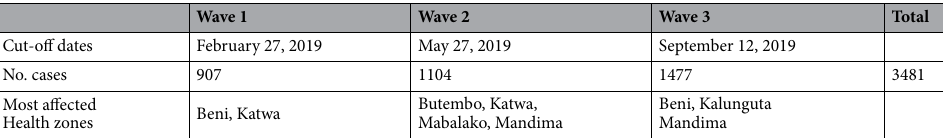
Table 1. Observed cases by EVD wave. The observed cases aggregated by 3 infection waves and the corresponding cutoff date for data collection. The number of cases observed in wave 3 by September 12 was 1113 with a combined total of 3117 cases across all three waves (see Fig.